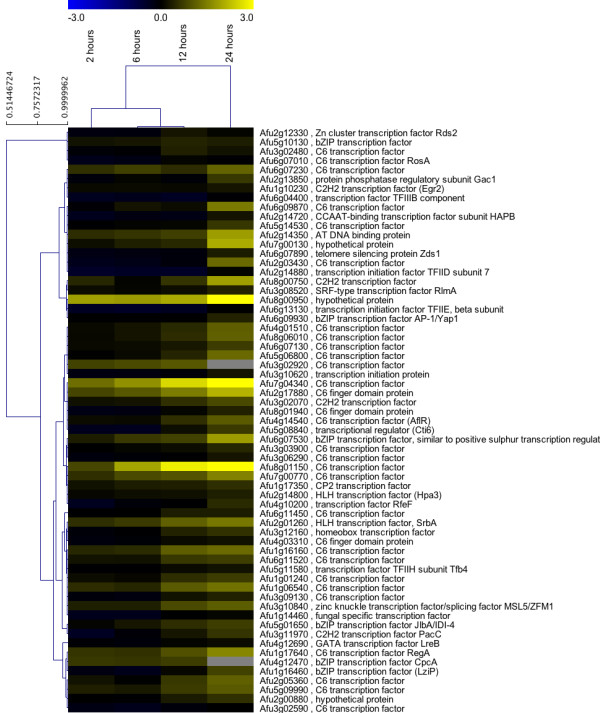
Self-organizing tree algorithm (SOTA) cluster associated with the transcription factor SrbA. A hierarchical tree generated from the median transcript levels of 63 transcription factors showing a similar transcript level profile with a known hypoxia responsive transcription factor SrbA identified from the SOTA analysis in Figure 12. Microarray datasets include three biological and two technical replicates. Microarrays compare wild type Aspergillus fumigatus strain CBS144.89 at the indicated times after exposure to hypoxic conditions to the time point immediately prior to hypoxia exposure (0 hours). Yellow indicates transcript level is higher in hypoxia.